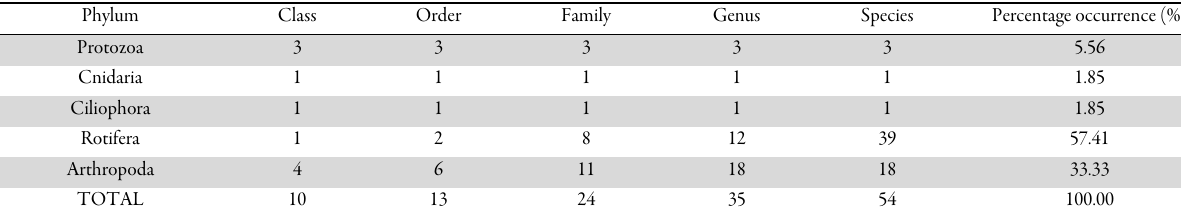
Fig. 2. Taxonomic composition of recorded species of zooplankton taxa Table 2. Outline classification and taxa composition of the zooplankton fauna